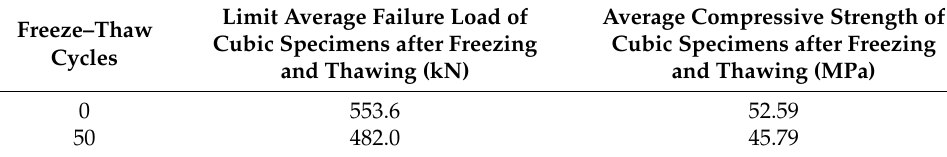
Table 6. Compressive strength test results of concrete cubic